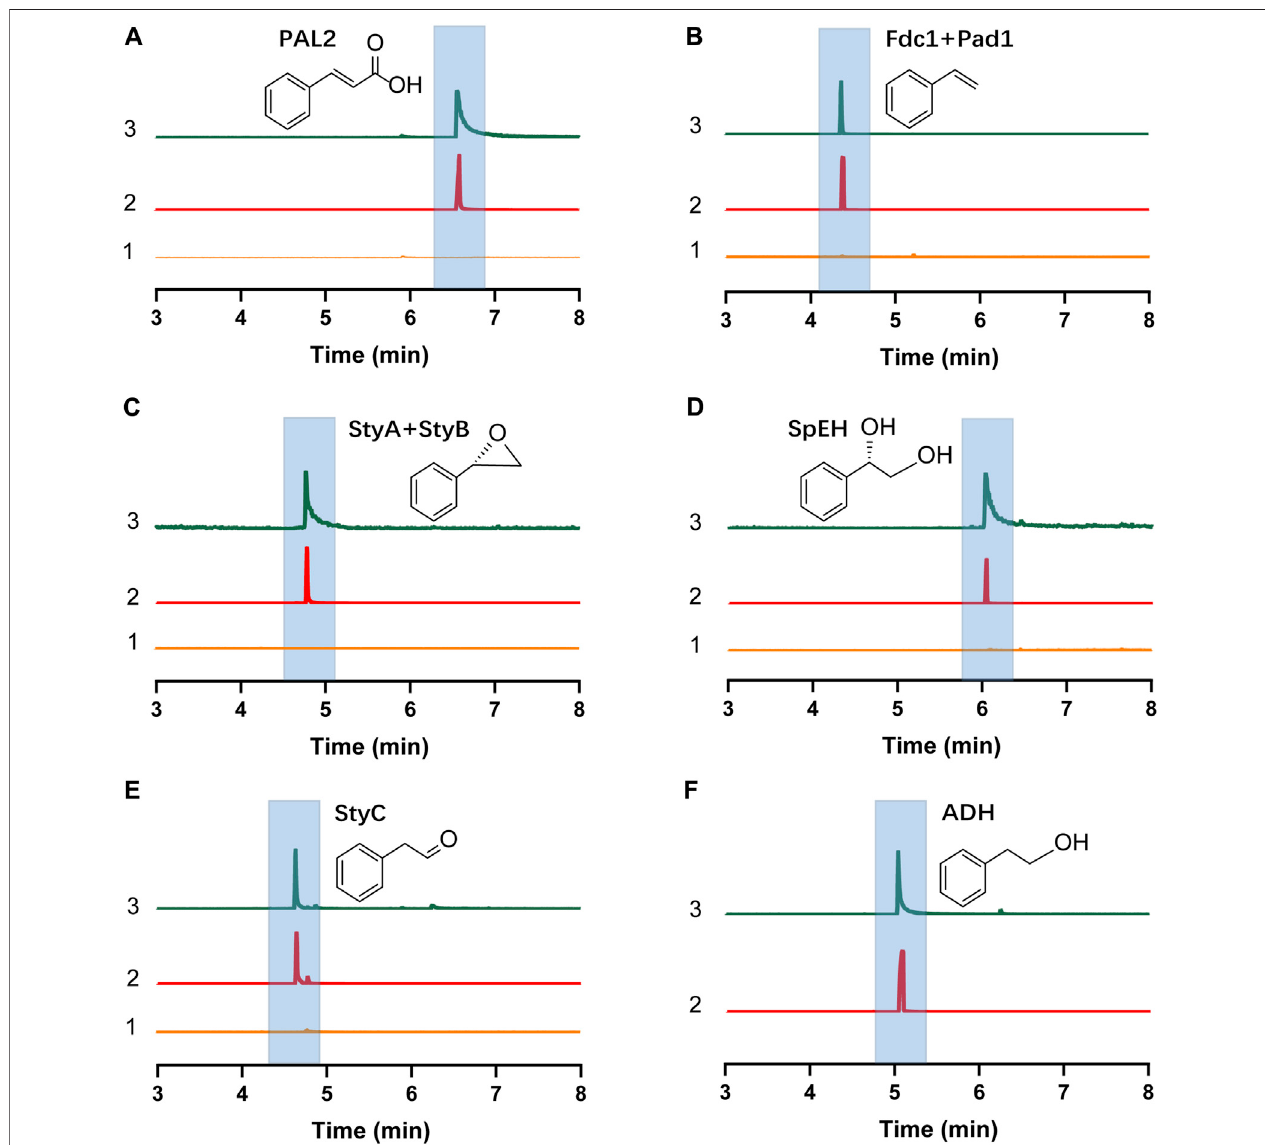
FIGURE 2 | GC-MS detection of the product of each step enzymatic reaction. (A) Cinnamic acid. (B) Styrene. (C) Styrene oxide. (D) (S) -PED. (E) Phenylacetaldehyde. (F) 2-PE. In each panel, the numbers 1, 2, and 3 represent negativecontrol without plasmid in the CFPS reaction (substrate was added), chemical standard,andcell-freereactionsample,respectively.Notethatin (F) ,noexogenousenzymeswereexpressed inCFPSandonly E.coli endogenousADHscatalyzedthe